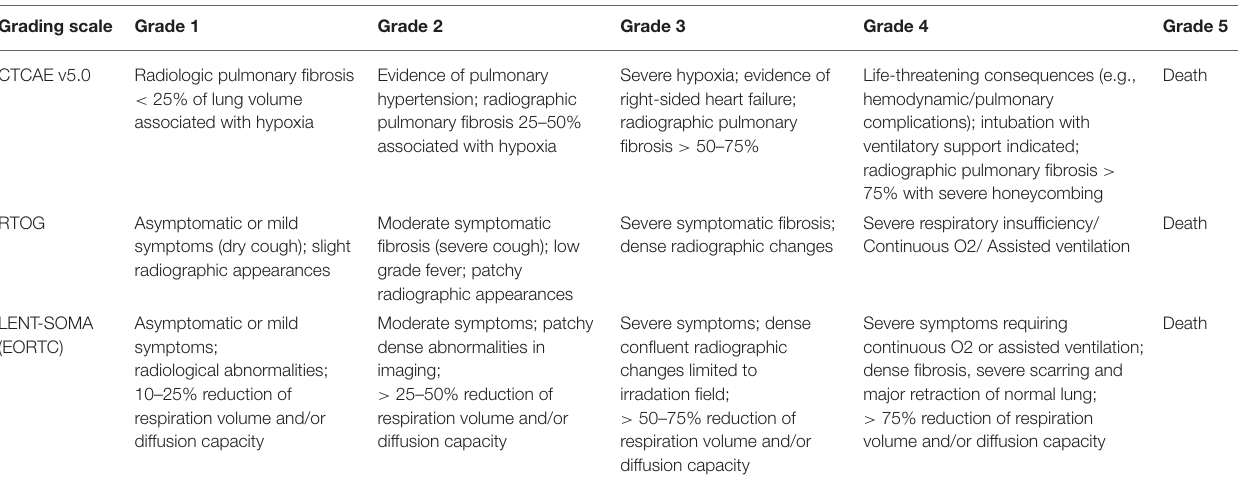
TABLE 2 | Overview about grading scales for radiation-induced lung fibrosis. Grading scale Grade